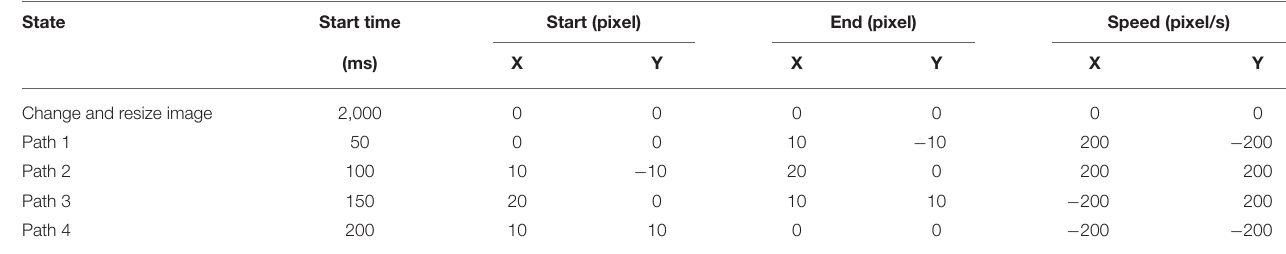
TABLE 2 | Parameters of image movement control component during the closed-loop